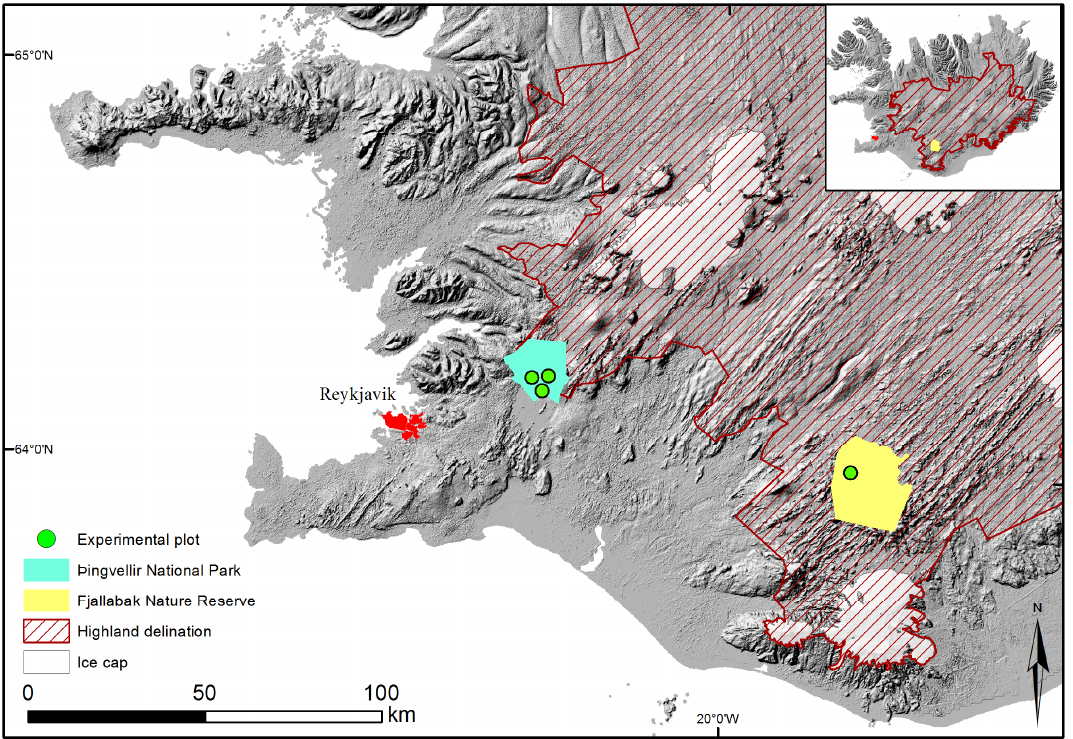
Figure 1. The location of the selected study areas, with Þingvellir National Park in the lowlands, Fjallabak Nature Reserve in the highlands, and the experimental plots (green dots).